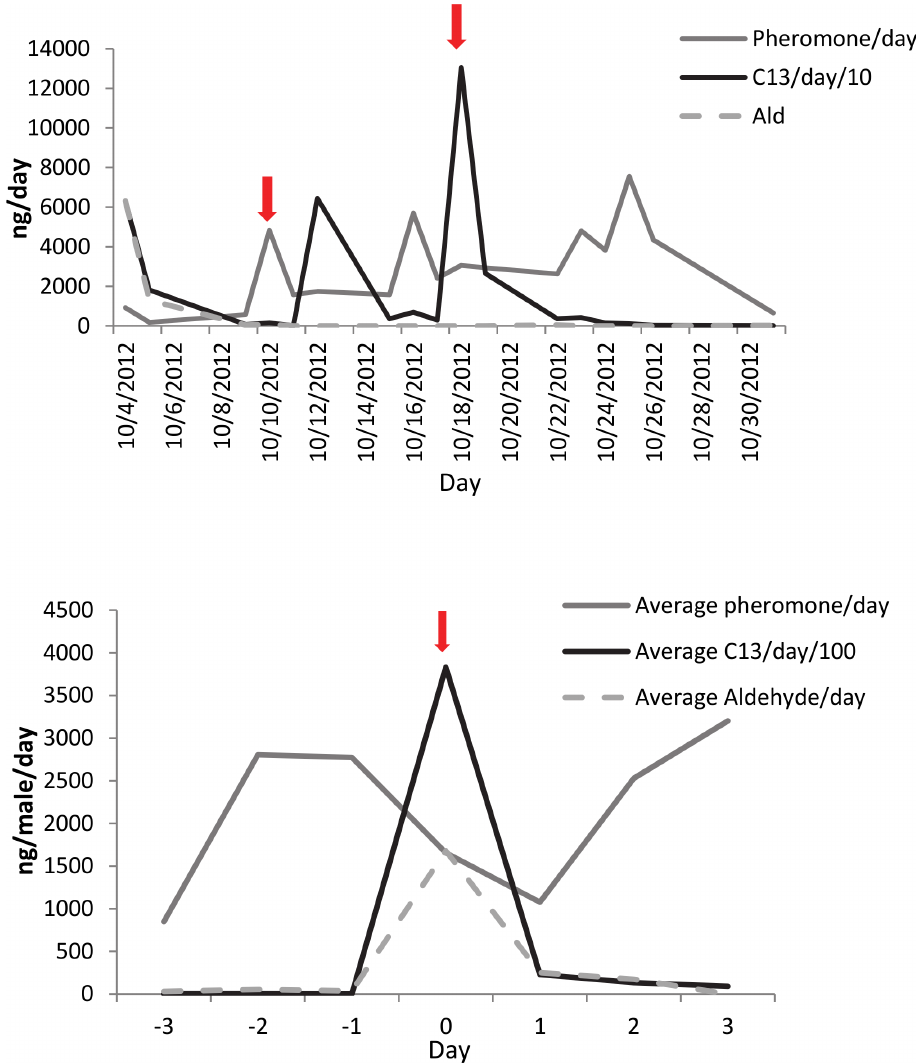
Fig 4. C13 effect on pheromone emission for one male. (A) Arrows indicate date that C13 was added to aeration jars (20 μ L on 10/11/12, 30 μ L on 10/17/12). (B) Average of single male pheromone emission with application of 20 μ L synthetic C13 added to aeration chambers on day 0 (n =